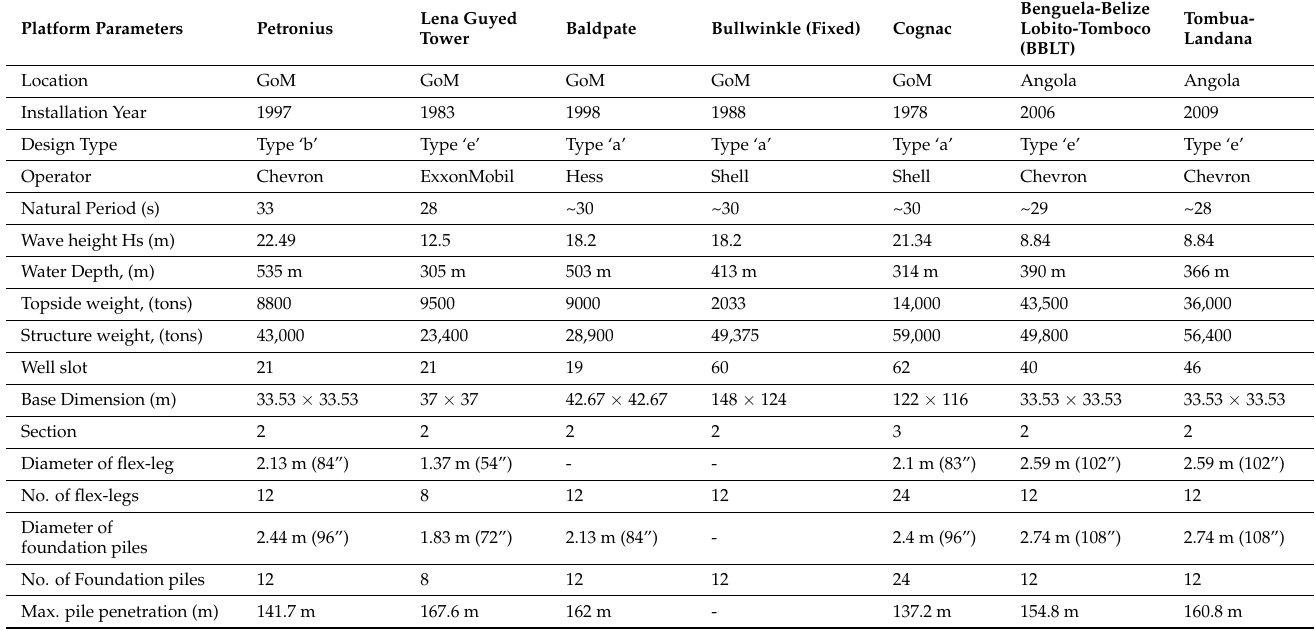
Figure 14. Illustrations showing ( a ) the Five Compliant Tower Platforms in the World including those sanctioned, installed and operating platforms while ( b ) shows a labelled compliant tower. (Revised image ( a ), adapted from Offshore Magazine Poster, Courtesy: Wood Group Mustang). Table 9. Parameters of compliant towers showing the structural